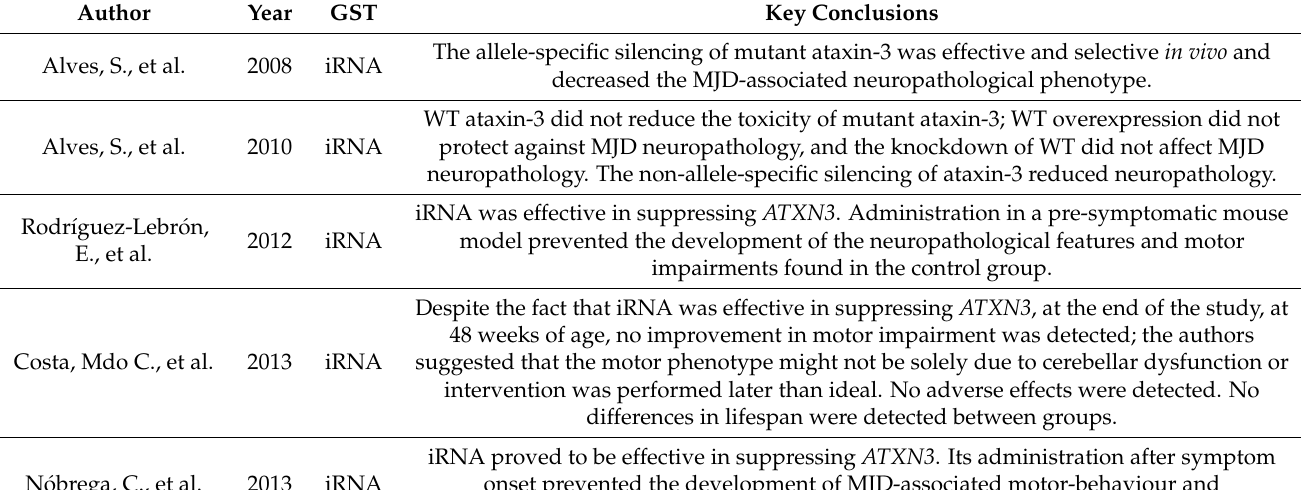
Table 1. Key conclusions from data extraction sheet—MJD/SCA3